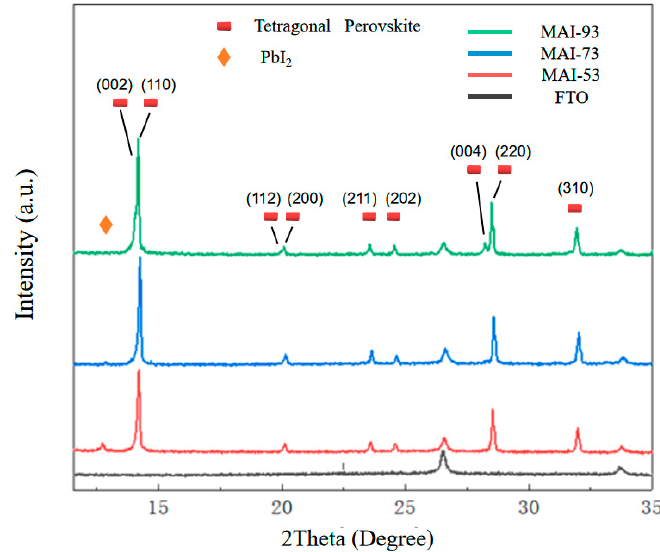
Figure 5. SEM cross-sectional views of organic–inorganic hybrid perovskite films with different concentrations of MAI precursor solution. ( a – c ) show the films with MAI concentrations of 53 mg/mL, 73 mg/mL, and 93 mg/mL, respectively.